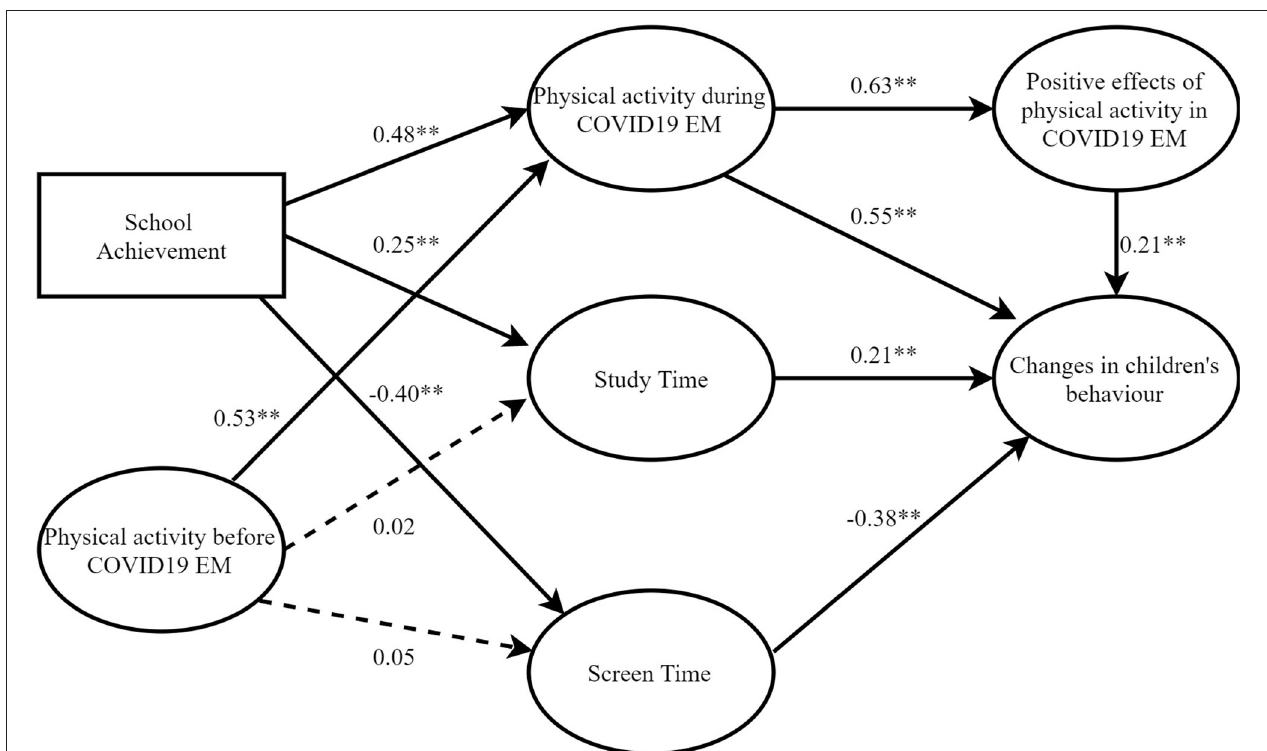
FIGURE 2 | The results of the proposed hypothesized model - Direct and Indirect Impact of School Achievement, Physical Activity before COVID19 EM, Physical Activity during COVID19 EM, Study Time and Screen Time on Changes in children’s